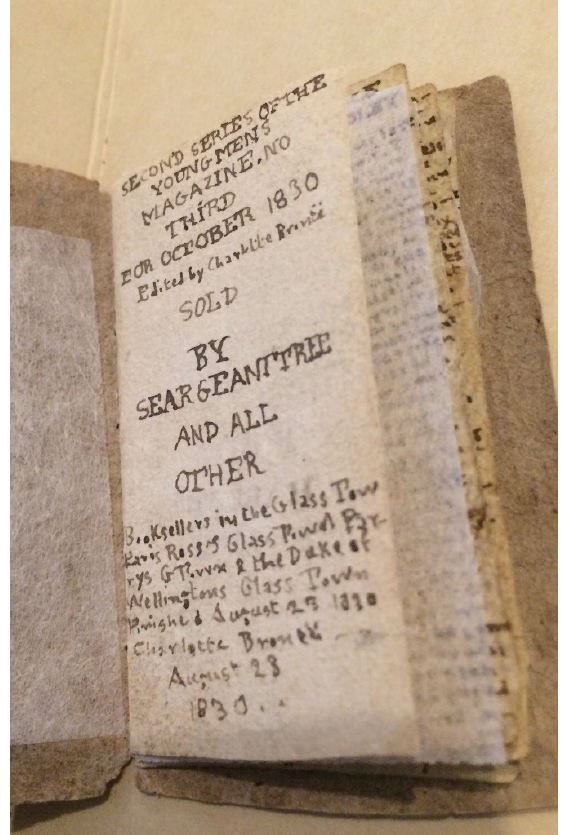
Figure 2. Title page of the October 1830 Young Men’s Magazine pictured above.